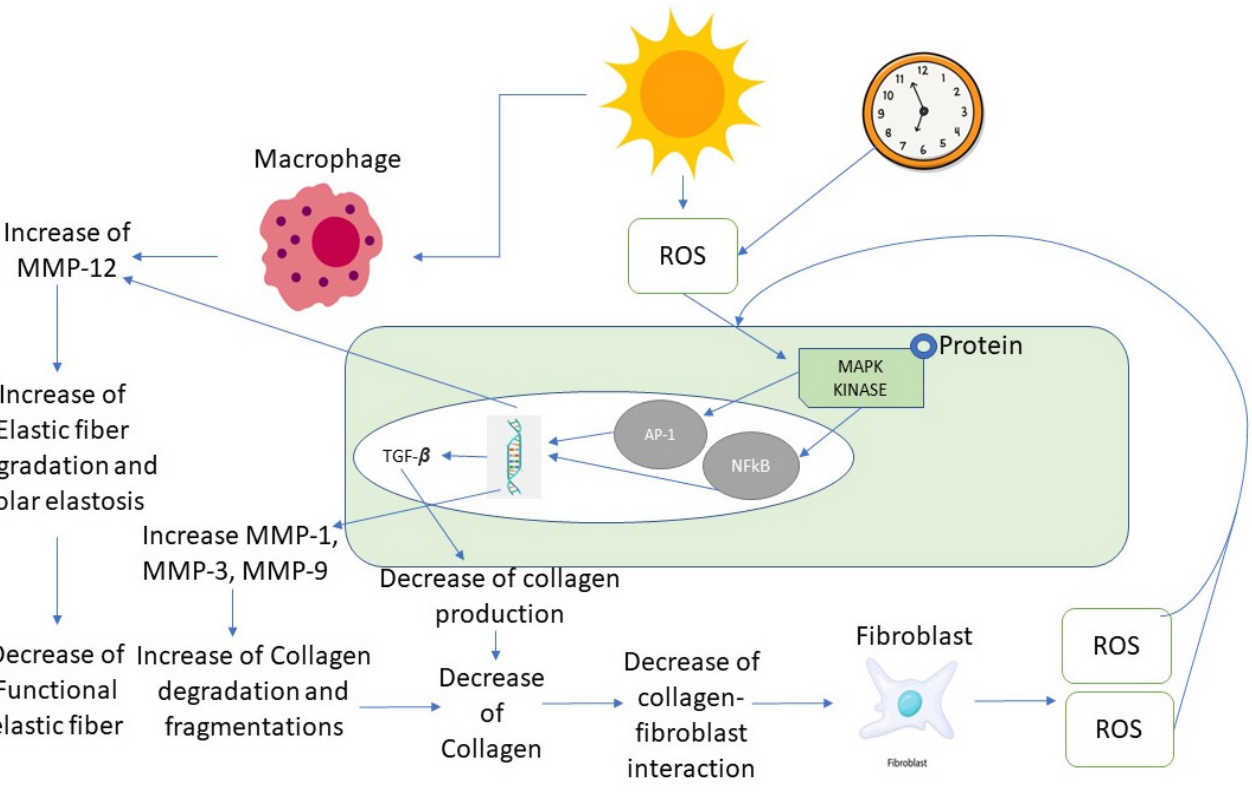
Figure 1. Skin aging process [Reproduced from